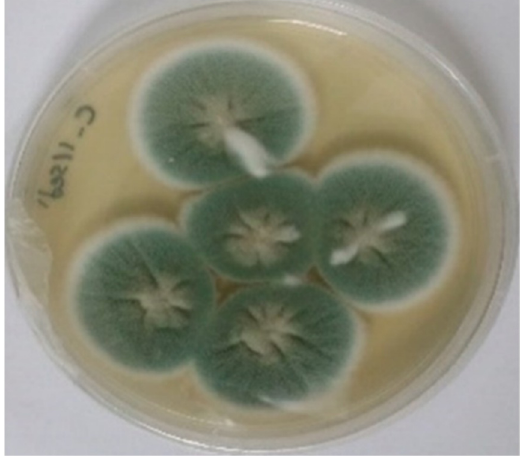
Figure 1. A morphological photo of P. chrysogenum strain S003 [22].